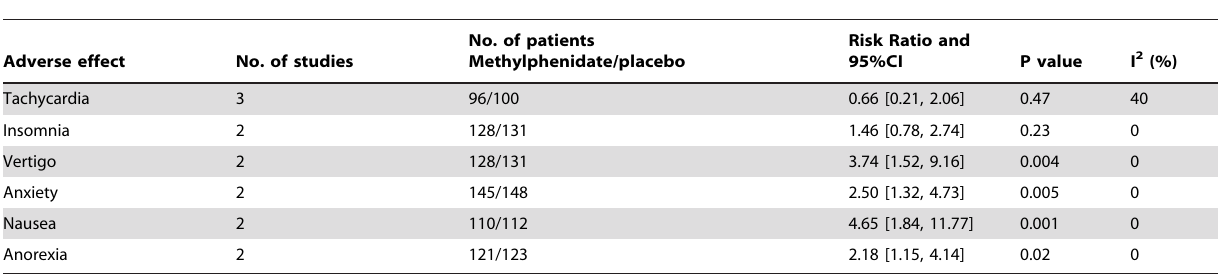
Table 2. The pooled adverse effects of Methylphenidate in included